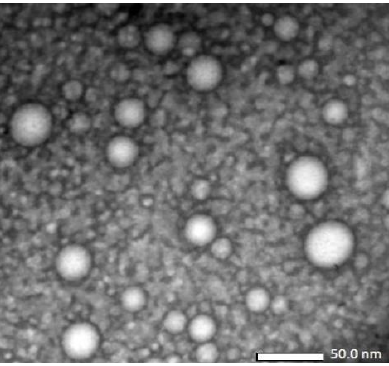
Figure 1. Cryo-transmission electron microscopic (cryo-TEM) observation of blank nanoemulsion (10,000× magnification).